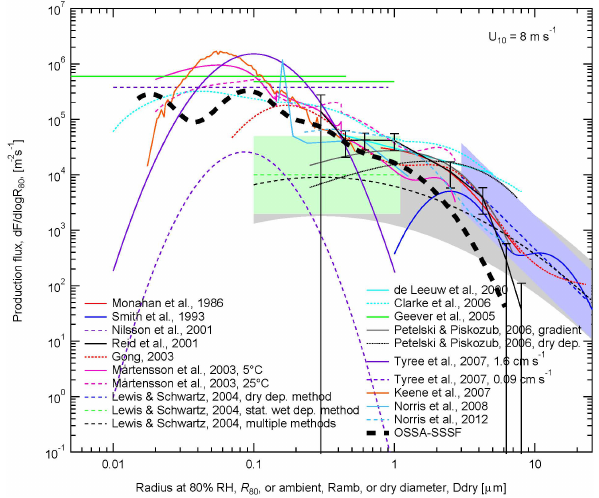
Fig. 7. Comparison of the sea spray aerosol source function de- rived in this study (OSSA-SSSF) with other SSSF (Monahan et al., 1986; Smith et al., 1993; de Leeuw et al., 2000; Nilsson et al., 2001; Reid et al., 2001; Gong, 2003; Mårtensson et al., 2003; Lewis and Schwartz, 2004; Geever et al., 2005; Clarke et al., 2006; Pe- telski and Piskozub, 2006; Keene et al., 2007; Tyree et al., 2007; Norris et al., 2008; Norris et al., 2012), evaluated for wind speed U 10 =8ms − 1 (or U 22 =8ms − 1 for Geever et al. (2005). Also shown are central values (curves) and associated uncertainty ranges (bands) from review of Lewis and Schwartz (2004), which denote subjective estimates by those investigators based on the statistical wet deposition method (green), the steady state deposition method (blue), and taking into account all available methods (gray); no es- timate was provided for R 80 <0.1µm. Lower axis denotes radius at 80% relative humidity, R 80 , except for formulations of Nilsson et al. (2001), Mårtensson et al. (2003), and Clarke et al. (2006) which are in terms of dry particle diameter, D dry , approximately equal to R 80 and those of Geever et al. (2005), Petelski and Piskozub (2006) (dry deposition method), and Norris et al. (2008), which are in terms of ambient radius, R amb . Formulations of Tyree et al. (2007) are for artificial seawater of salinity 33 at the two specified bubble vol- ume fluxes. Formulations of Nilsson et al. (2001) and Geever et al. (2005) of particle number production flux without size resolu- tion are plotted arbitrarily as if the flux is independent of R amb over the size ranges indicated to yield the measured number flux as an in- tegral over that range. (Figure and caption modified from de Leeuw et al.